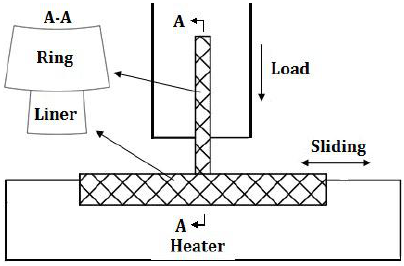
Figure 1. Piston ring reciprocating cylinder liner test